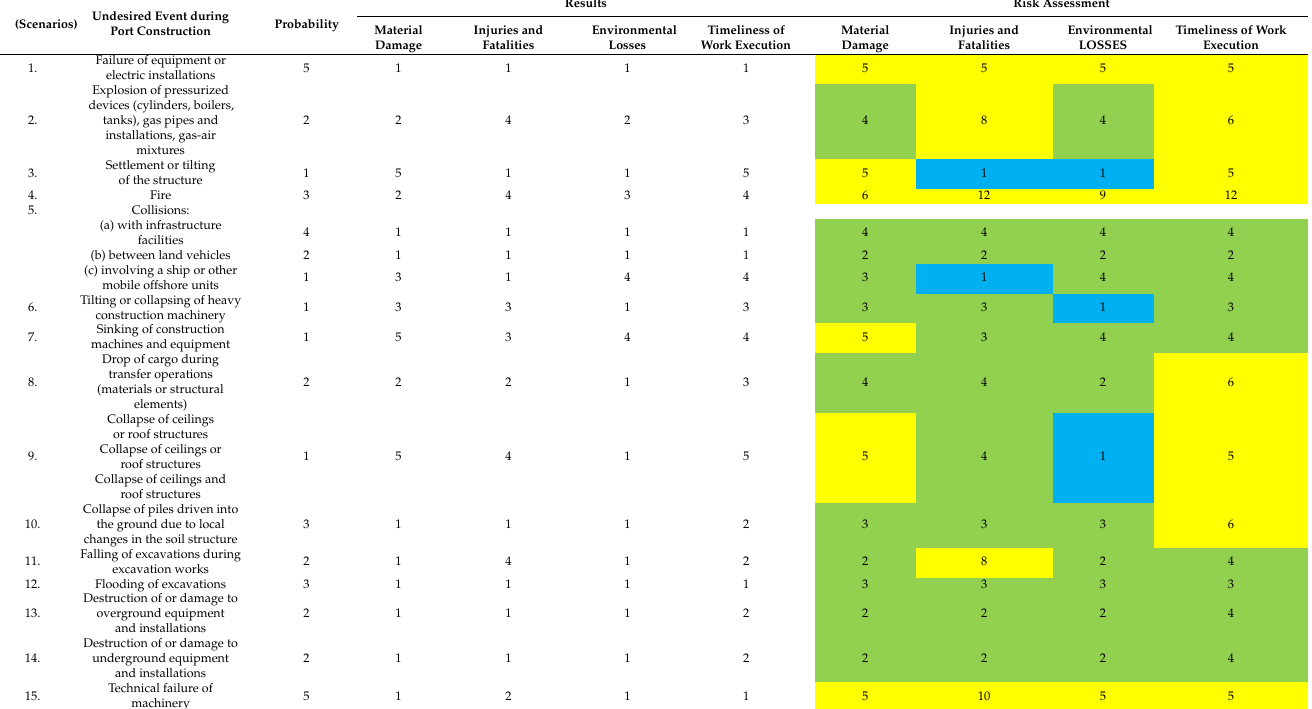
Table 8. Risk assessment of in-port construction